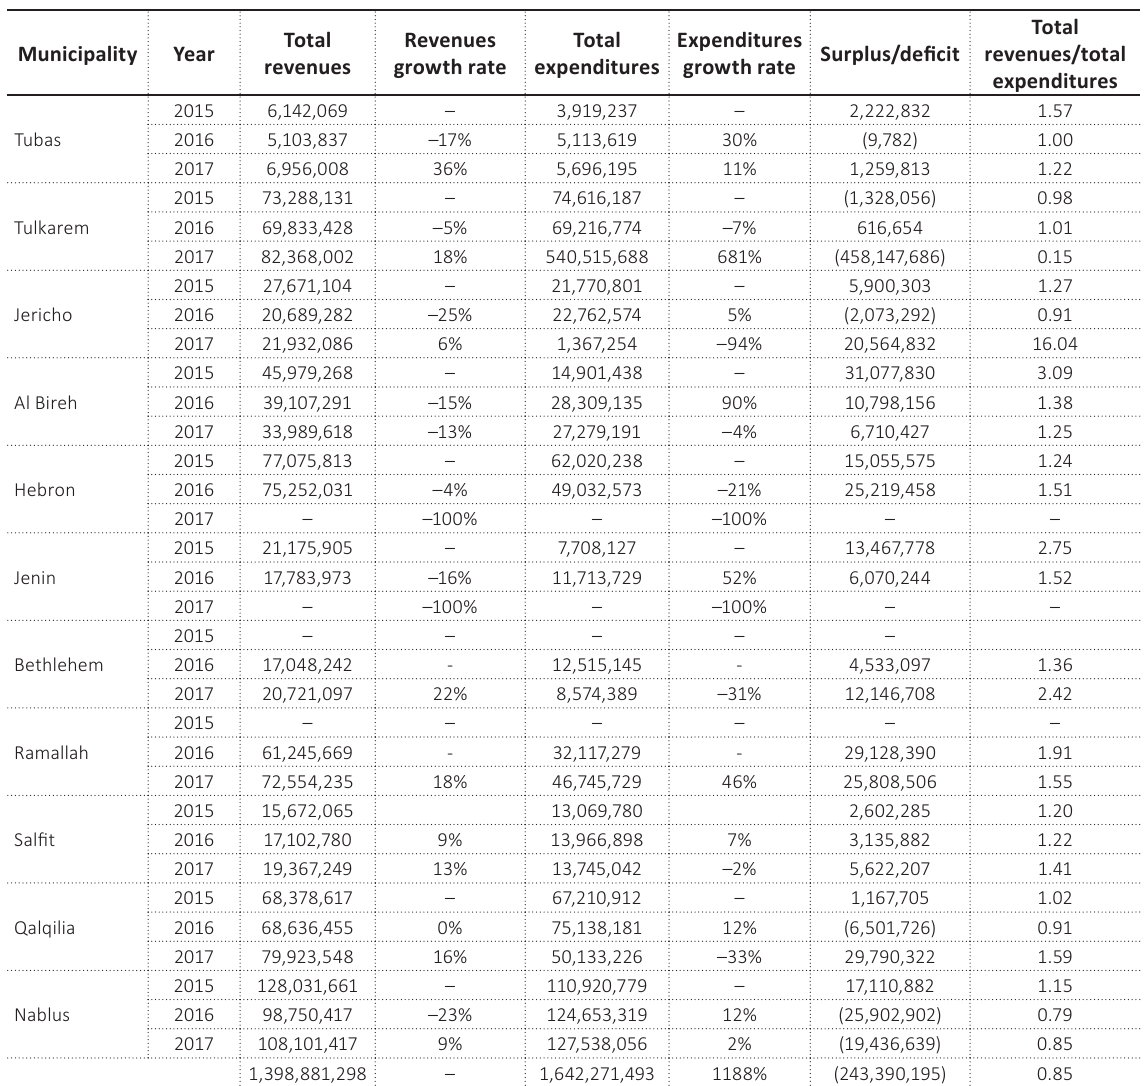
Table 7. Revenues and expenditures analysis